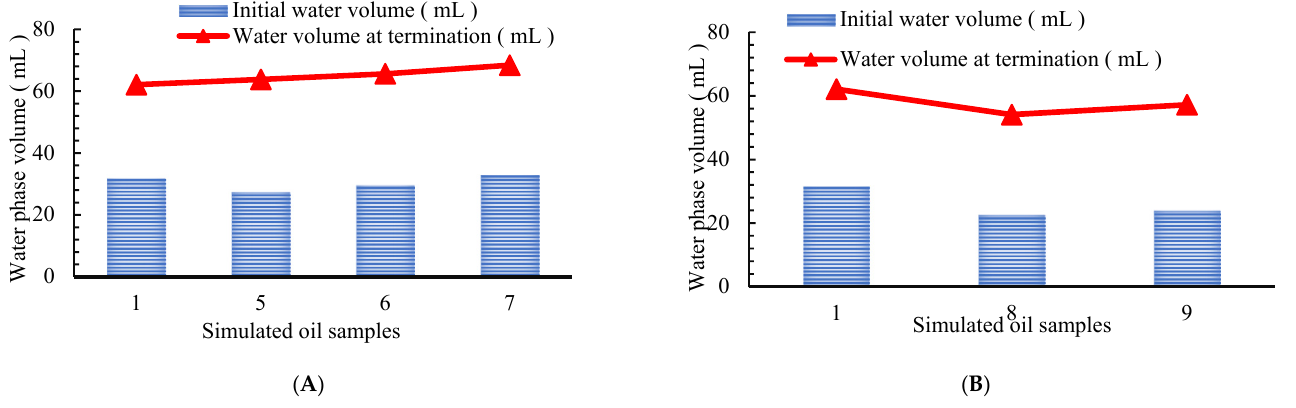
Figure 12. Influence of unsaturated hydrocarbon on emulsifying effect of crude oil. ( A ) The effect of aromatic hydrocarbon content on emulsifying effect. ( B ) Influence of colloid and asphaltene on the emulsifying effect.